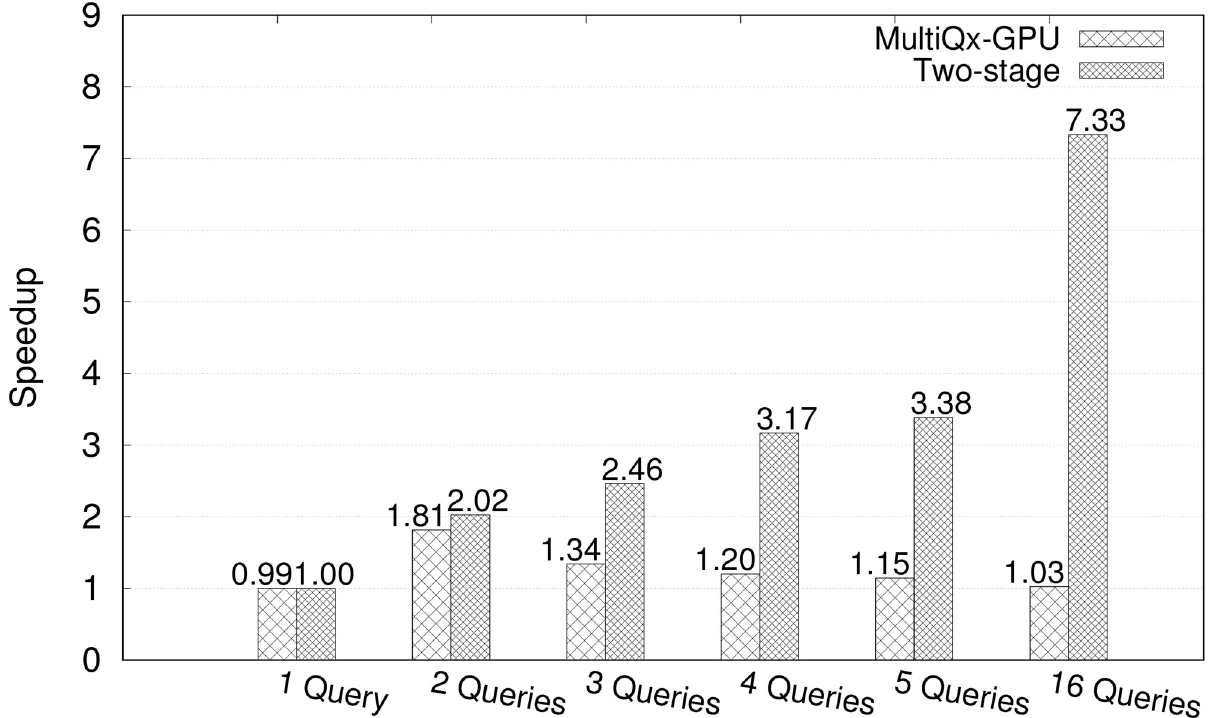
Fig 10. Speedup of different number of queries that MultiQx-GPU Optimization and Two-stage Model over sequential solution.